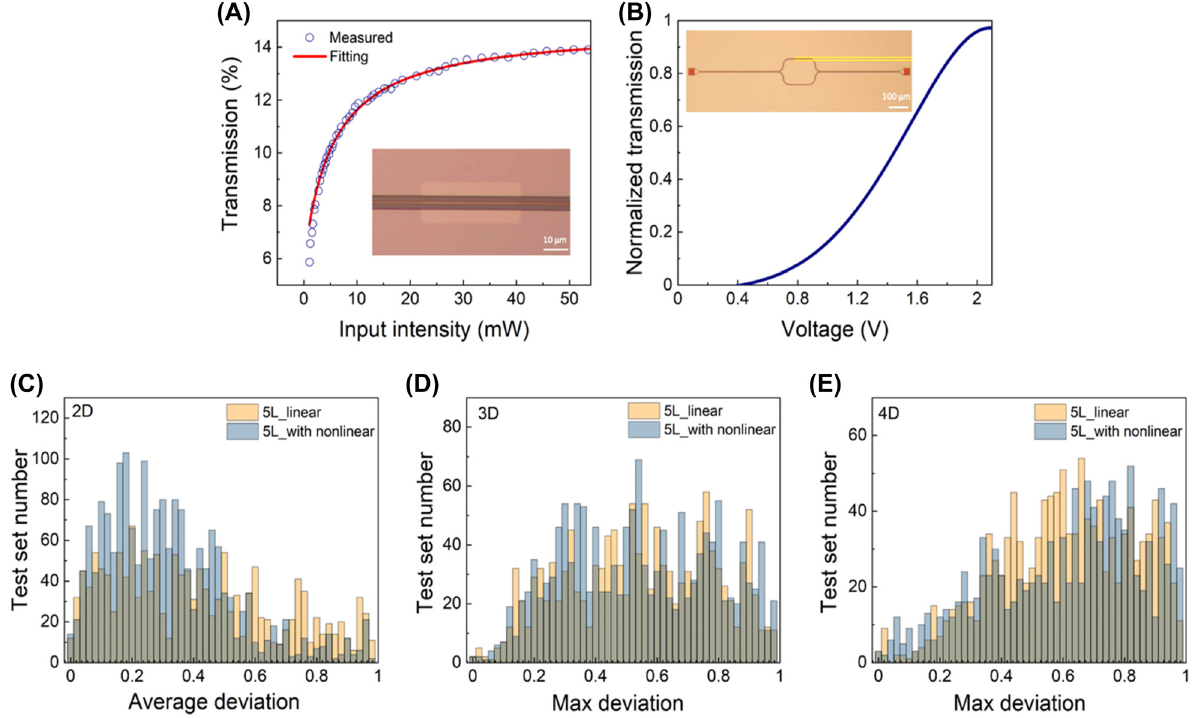
Figure 4: Reconfigurable photonic neural network for matrix eigenvalue solver. (A) The optical nonlinear activation layer of single-layer graphene covered on the waveguide with the length of 40 μ m. The home-built femtosecond pulse fi ber laser system (central wavelength: 1560 nm, pulse width: 80 fs) is used as the light source. The fi tting parameters are α α S = 0.088 NS = 0.852 I s = 5.446. Inset: the optical micrograph of optical nonlinear activation cell. (B) The change curve of normalized light intensitytransmissionwithmodulationvoltageinthetestinterferencestructureofopticalwaveguidewith V π =2.11Vand P π =10.2mW.Inset: theopticalmicrographofthermal-opticalmodulatedtestinterferencestructureofopticalwaveguide.(C – E)Distributionsoftheexperimentally measured test set with deviation of eigenvalues of different order matrices for 5L and 5L with nonlinear, with the 2 × 2 corresponding to the average deviation, 3 × 3 and 4 × 4 corresponding to the maximum